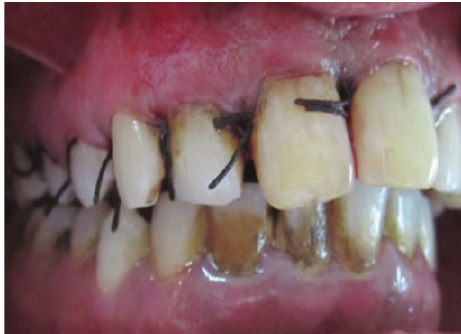
Figure 12: Suturing.